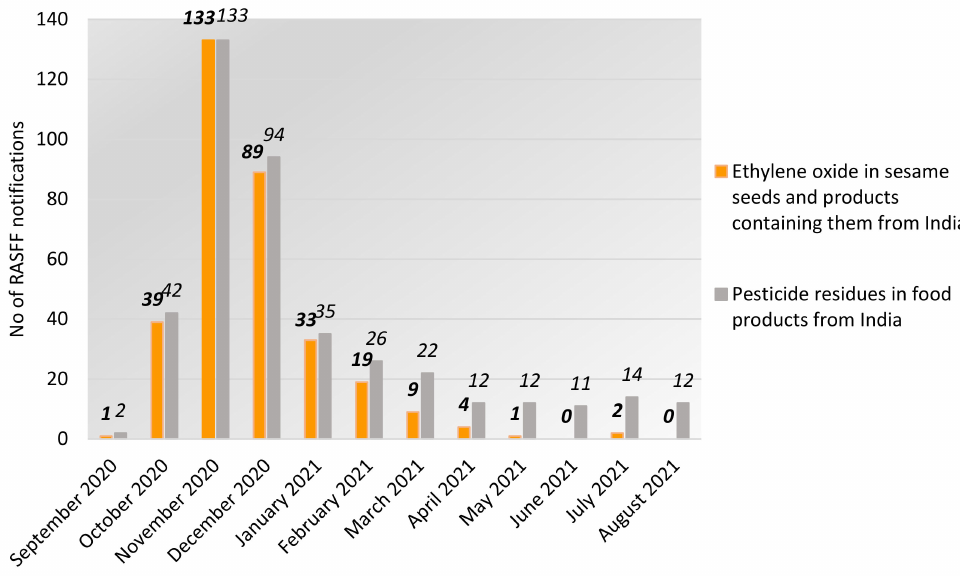
Figure 3. Food safety issues related to pesticide residues in food products from India notified to RASFF over the period September 2020–August 2021 (Source: Own elaboration based on